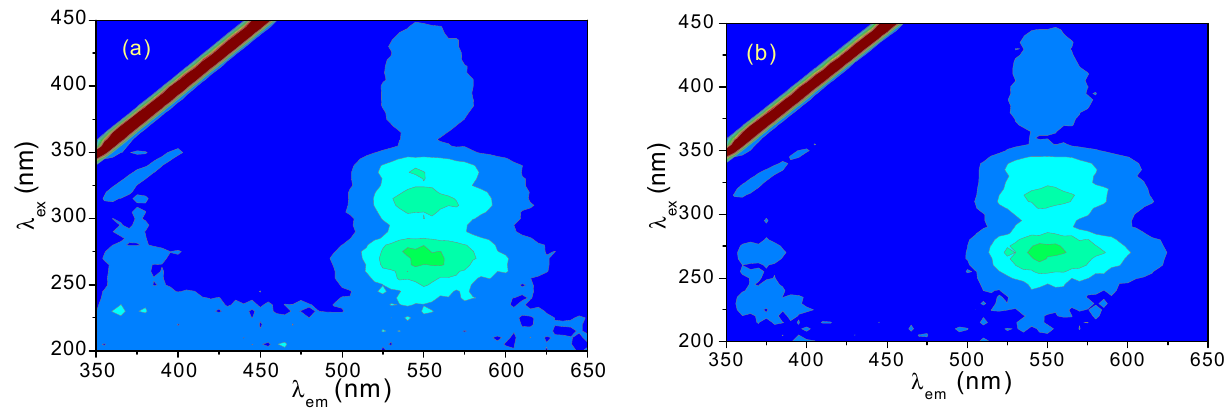
Figure 4. 3D fluorescence spectra of CH ( a ) and ECH ( b ) acidic aqueous solutions. c CH = 5.04 µ g · mL − 1 , c ECH = 5.20 µ g · mL − 1 , pH 1.9, MeOH 2.0%, contour interval: 50.